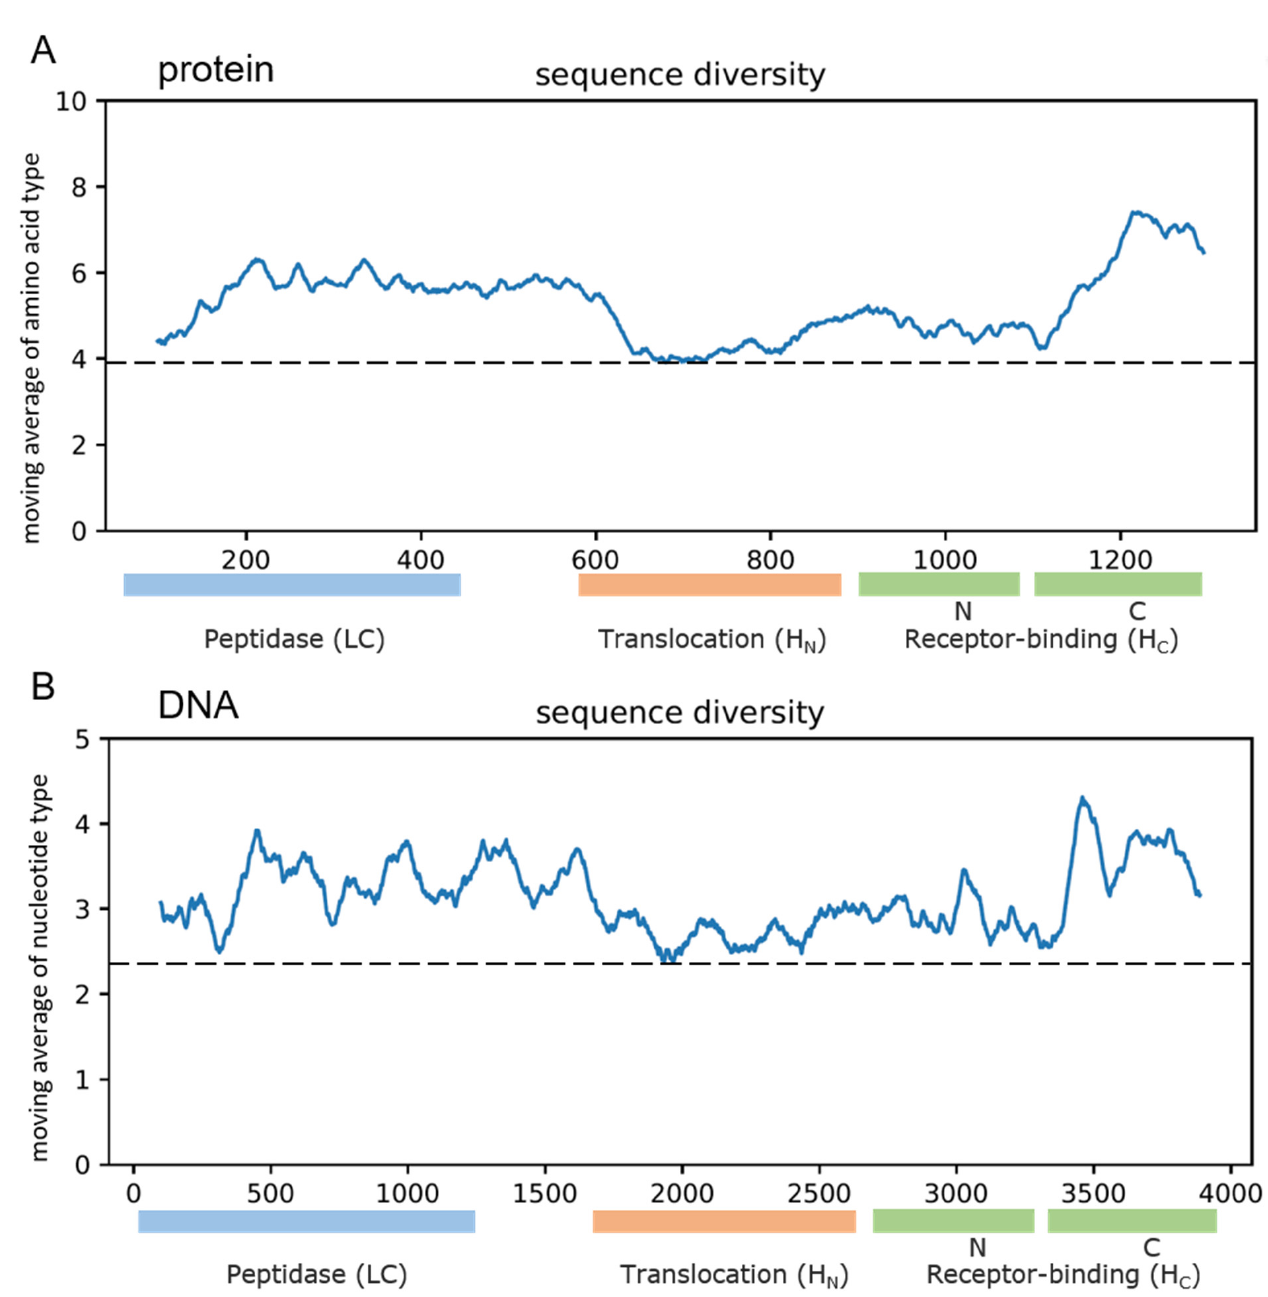
Figure 1. The amino acid and nucleotide diversity distribution of different regions of botulinum neurotoxin ( A ) protein and ( B ) gene, respectively. The diversity index (produced by counting the number of unique amino acids or nucleotides in each column in the multiple alignment files) of all of the positions were calculated using C. botulinum 62A BoNT gene as a reference. The moving average ( n = 100) of the diversity index was used to generate an overview of the sequence variation. The dashed black horizontal lines demarcate the lowest diversity value in the graph and are used only as visual aid.